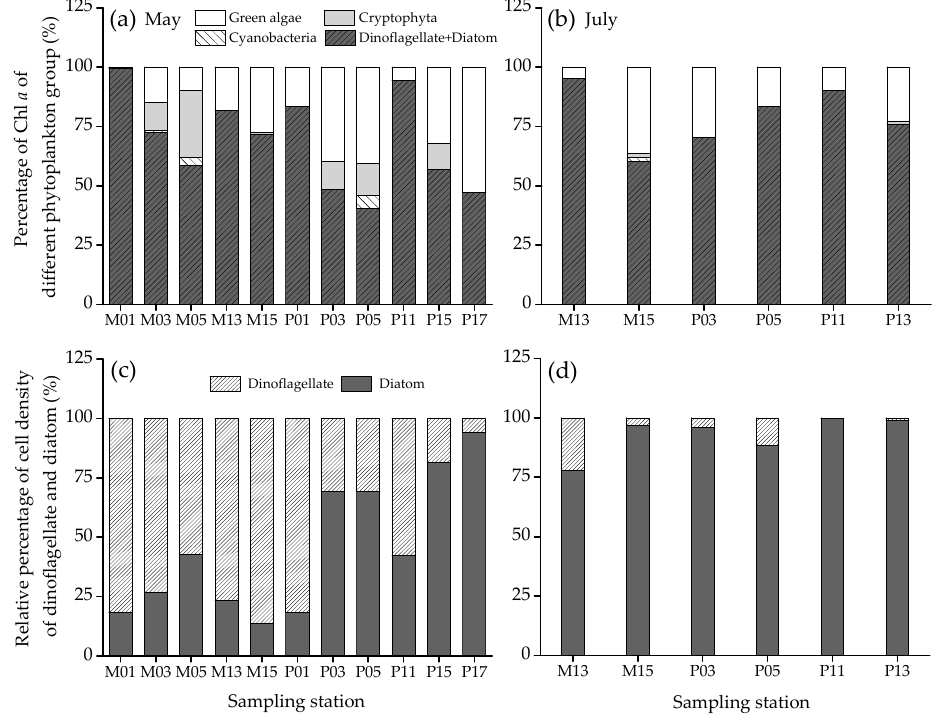
Figure 4. Percentage of Chl a of green algae, cryptophyta, cyanobacteria, dinoflagellates, and diatoms ( a , b ) in the phytoplankton community, and relative percentage of cell density of dinoflagellates and diatoms ( c , d ) in the surface water of the Taiwan Strait during the cruises in May ( left ) and July ( right ) 2019.